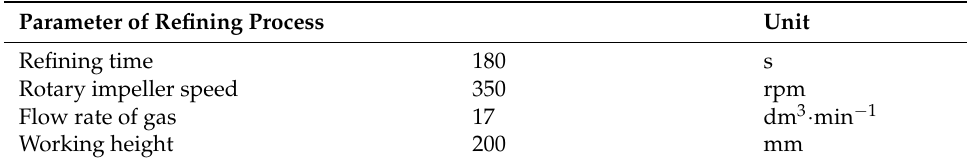
Table 2. Refining process parameters.